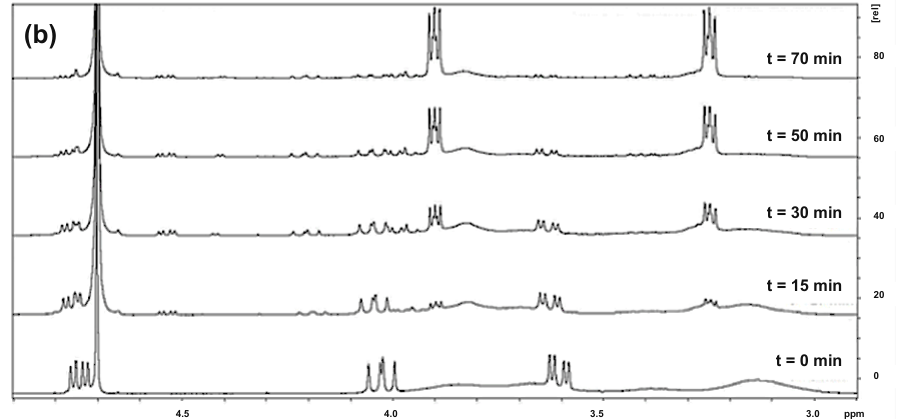
Figure 2. Reaction profiles for compound 3 , intermediate and reaction products. The signals consid-